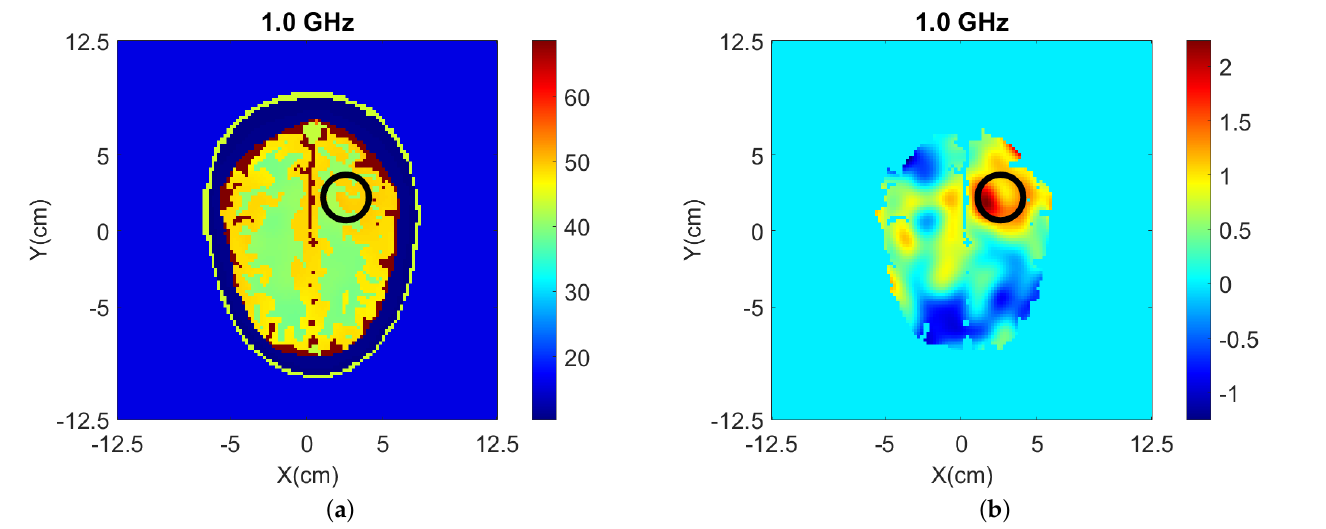
Figure 7. 2-D reconstructions of: ( a ) relative permittivity (cid:60) ( ε r ) and, ( b ) contrast (cid:60) ( δ ε ) for “Case I” of Figure 2 at 1.0